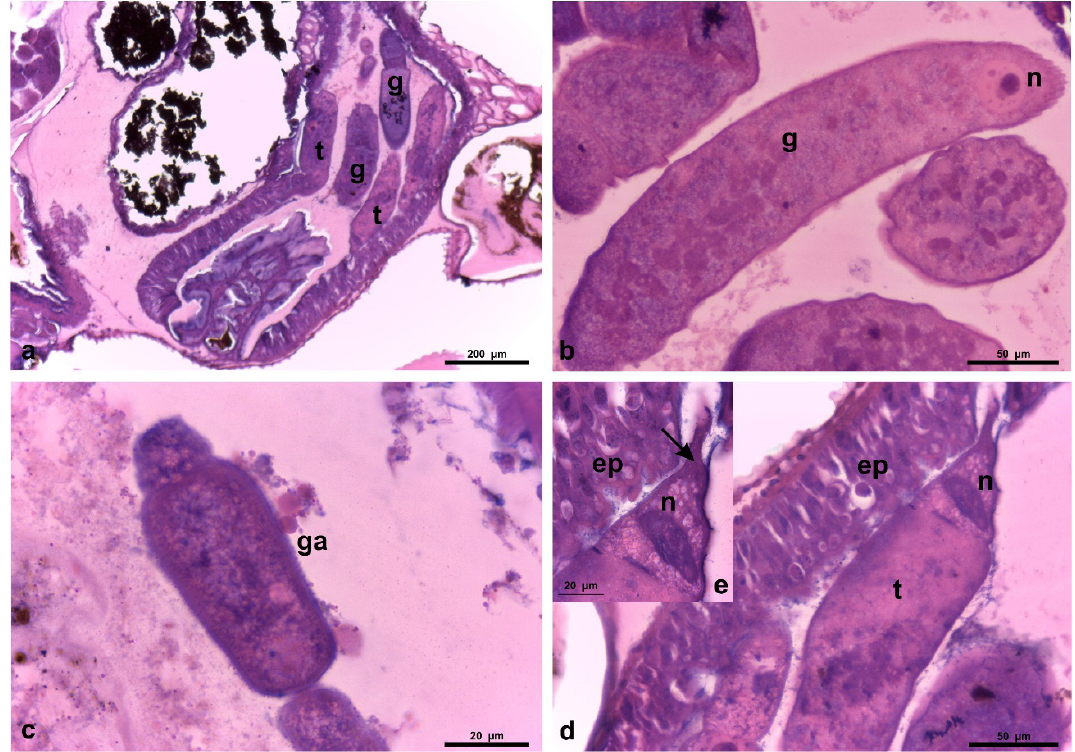
Fig 2 . Histological sections of the midgut of Ruptitermes pitan worker stained with toluidine blue/fuchsin. a Free gamonts (g) in the midgut lumen and trophozoite (t) attached to the mesenteric epithelium. b Detail of the free gamont (g) in longitudinal and transversal section. c Gamonts in syzygy (ga). d Trophozoite connected to the epithelium (ep). e Detail of the epimerite (arrow) which is a elongated structure used by the trophozoite (t) for connection to the in epithelium (ep). n =